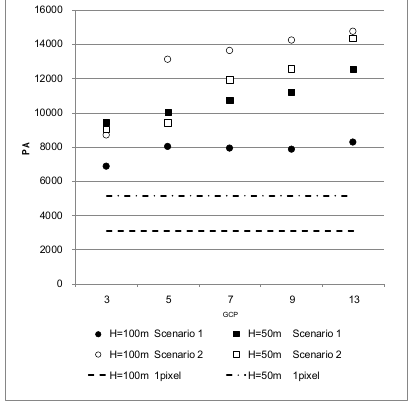
Figure 5. Function and accuracy